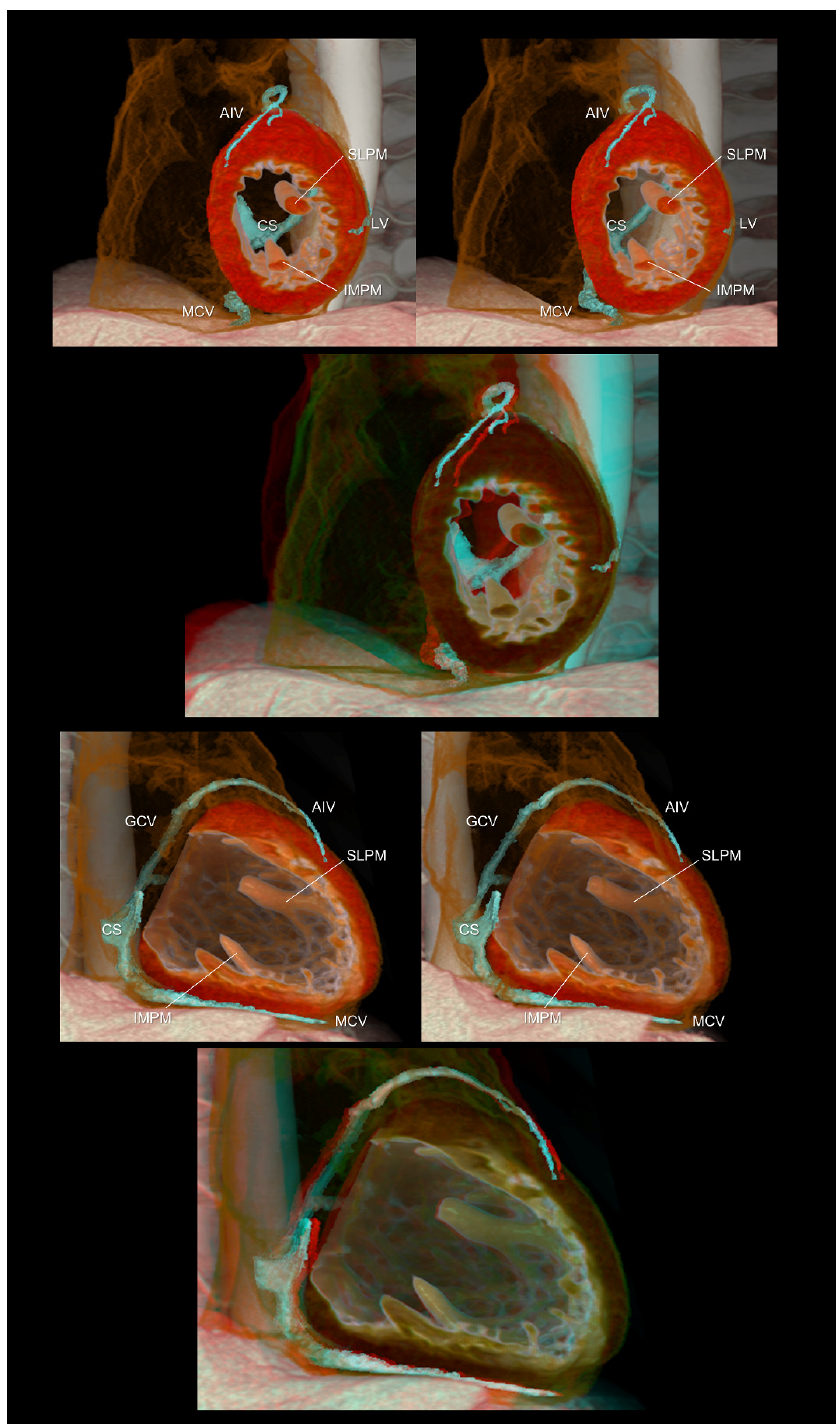
Figure 4. Left ventricular short ( upper panels ) and long ( lower panels ) axis images showing the relationship between the coronary veins and the left ventricular structures. The lateral vein, a candidate for left ventricular lead insertion for cardiac resynchronization therapy, runs in the region between the superolateral and inferomedial papillary muscles. The first and second panels are aligned for cross-eyed viewing. The third panel is the anaglyph. To see the anaglyph, anaglyphic glasses (red/cyan) are required. AIV, anterior interventricular vein; CS, coronary sinus; GCV, great cardiac vein; IMPM, inferomedial papillary muscle; LV, lateral vein; MCV, middle cardiac vein; SLPM, superolateral papillary